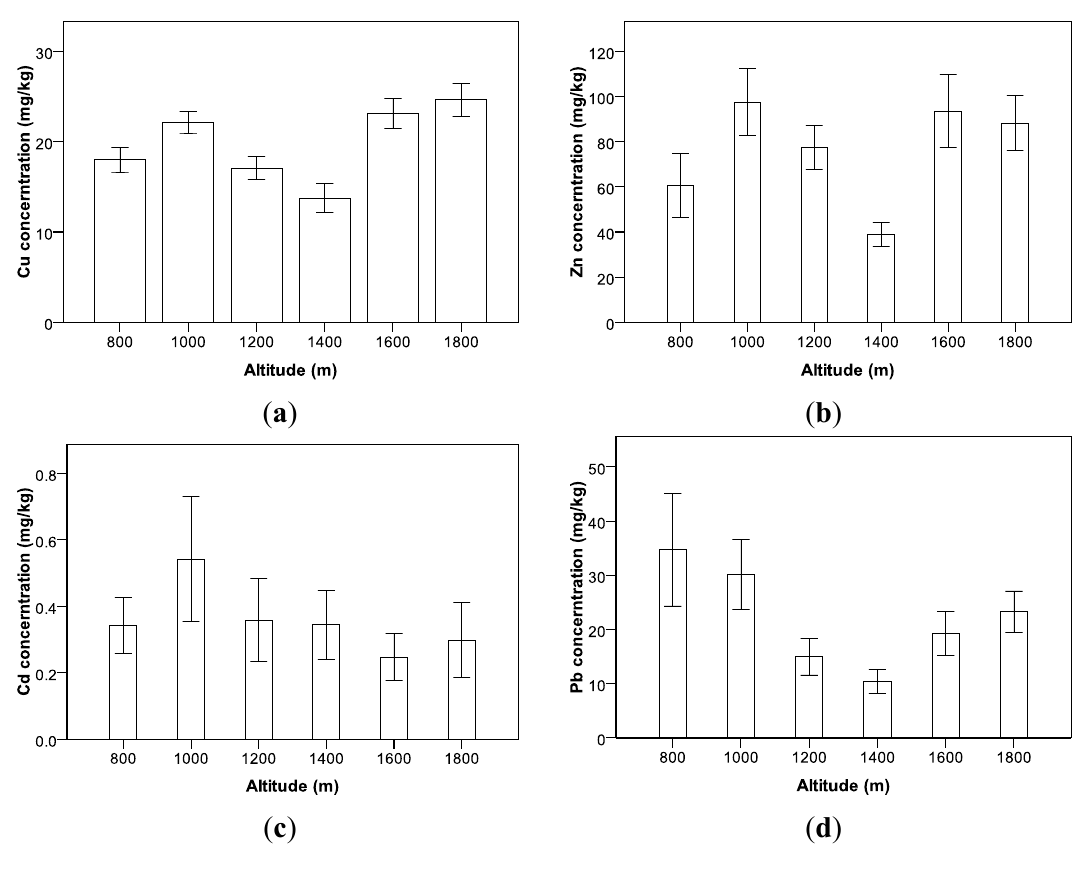
Figure 3. Variations in soil heavy metal concentrations with